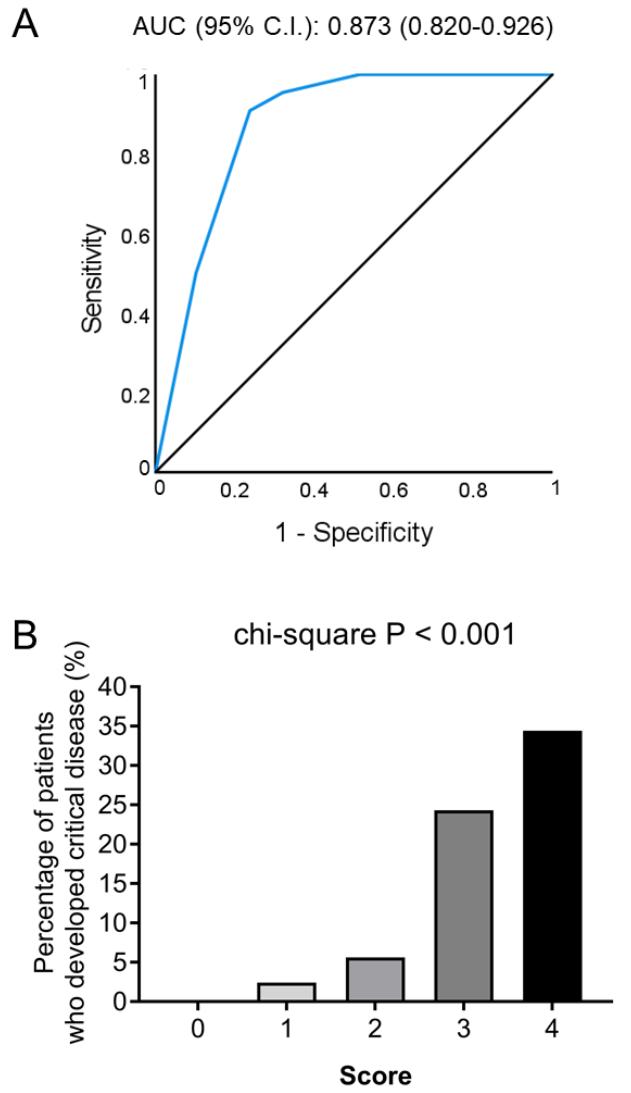
Figure 2. Predictive value of the simple score for the development of critical COVID-19 in the absence of comorbidities (derivation cohort). ( A ). Receiver operating characteristic (ROC) analysis of the simple score for discriminating patients with critical vs non-critical COVID-19. ( B ). Bars represent the percentage of patients who developed critical COVID-19 according to their score (0–4). Abbreviations: AUC: area under the curve, CI: confidence interval.